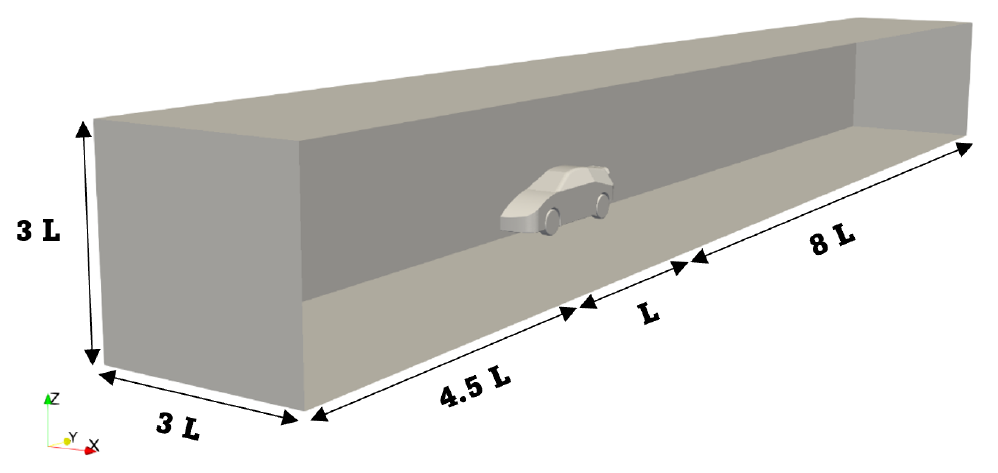
Figure 12. Dimensionless magnitudes of the fluid domain’s